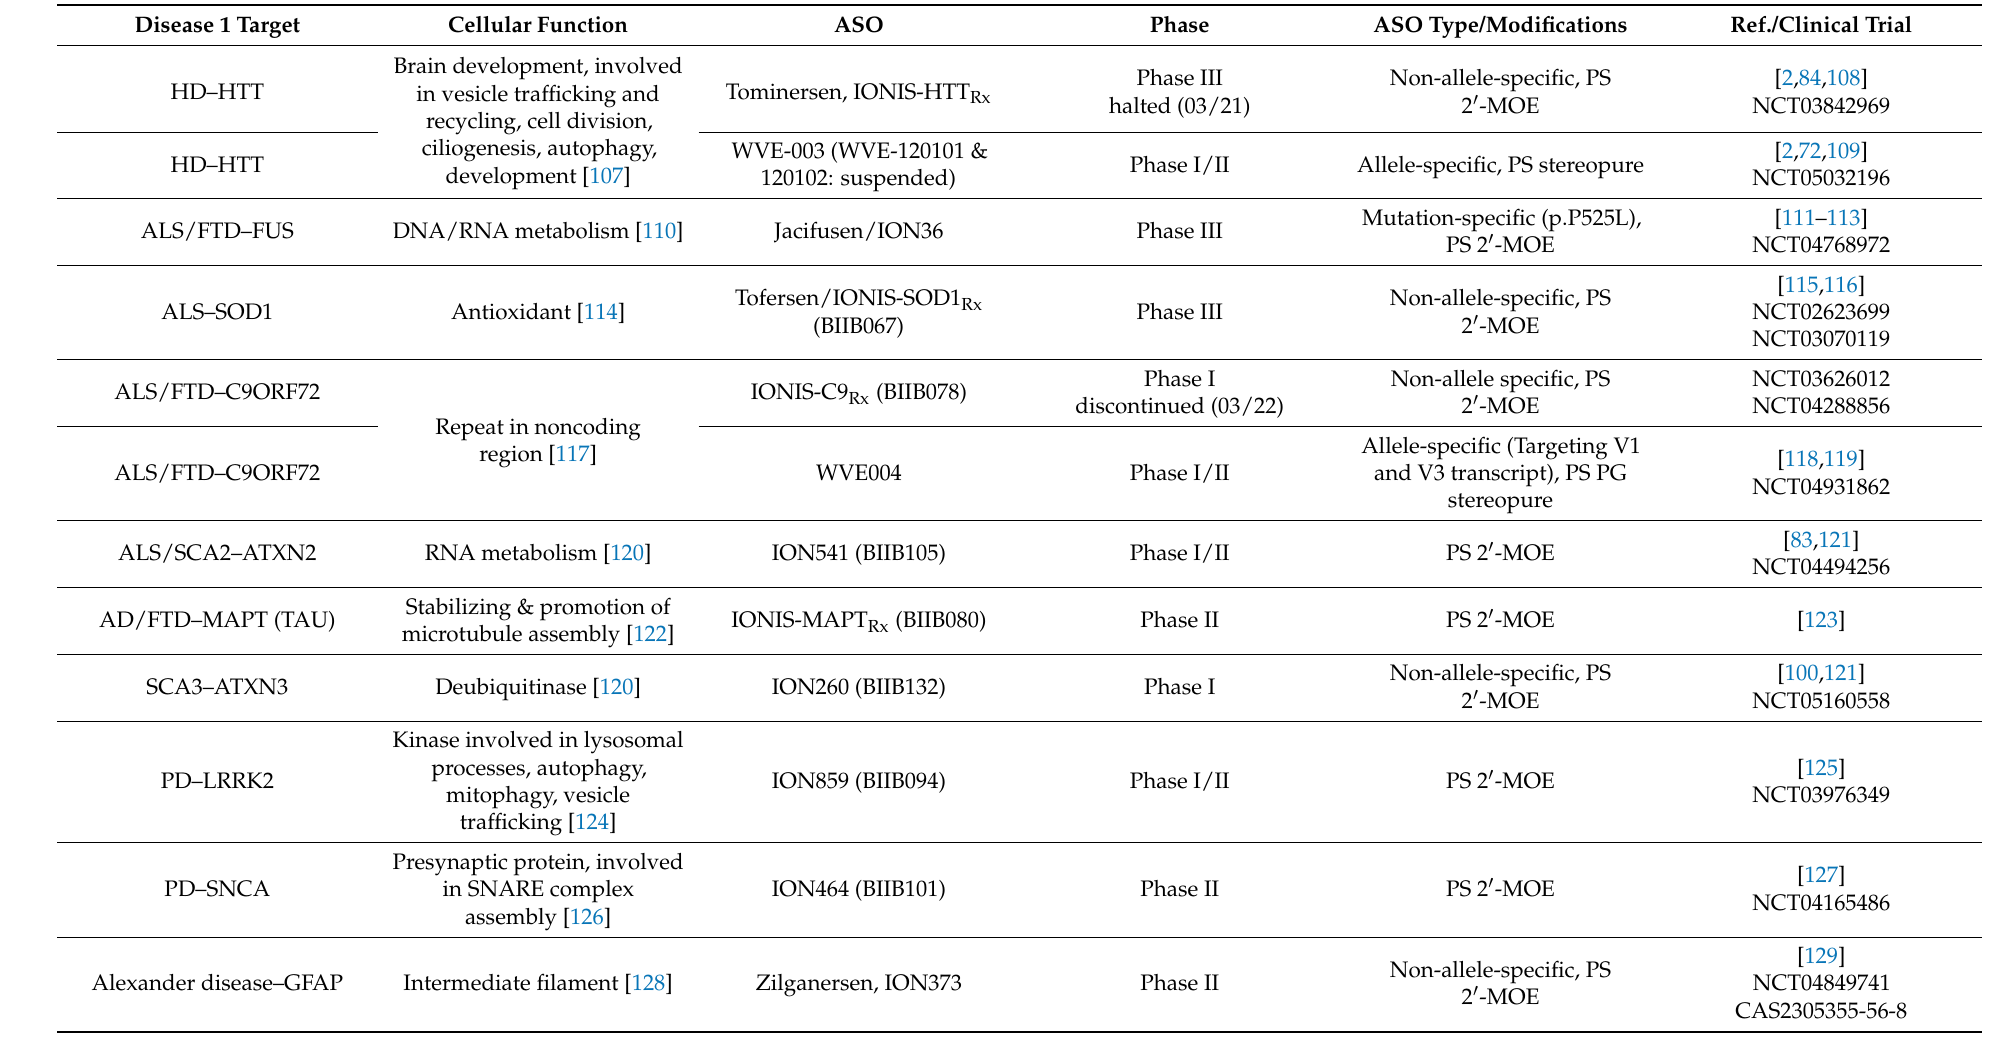
Table 2. Clinical trials of antisense oligonucleotides in toxic gain-of-function neurodegenerative